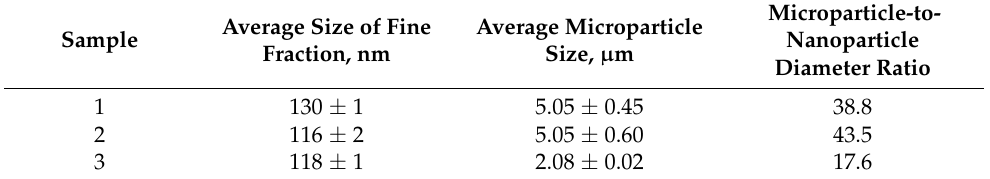
Table 3. Characteristics of the Particles Obtained at Different Energy Levels Input into Wires.